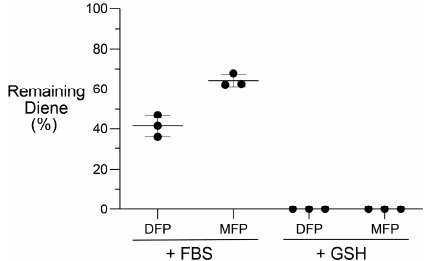
Figure 3. Stability of 44,-difluoro-4-methyl-3,5-diphenyl-4 H -pyrazole (DFP) and 4-fluoro-4-methyl- 3,5-diphenyl-4 H -pyrazole (MFP) in the presence of fetal bovine serum (FBS) or glutathione (GSH). Percent remaining was determined after an 8 h incubation at 37 °C as measured by UV-vis spectroscopy. In the presence of FBS, (42 ± 5)% and (64 ± 3)% of the DFP and MFP remained intact, respectively. No diene was detectable in the presence of GSH. Data for the stability of DFP in the presence of FBS are from [11].